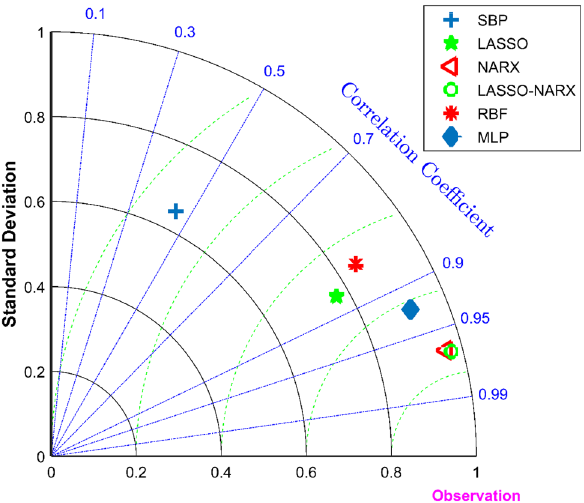
Figure 8. Taylor diagrams of predicted values of five models and measured values of self-built points, where SBP stands for self-built